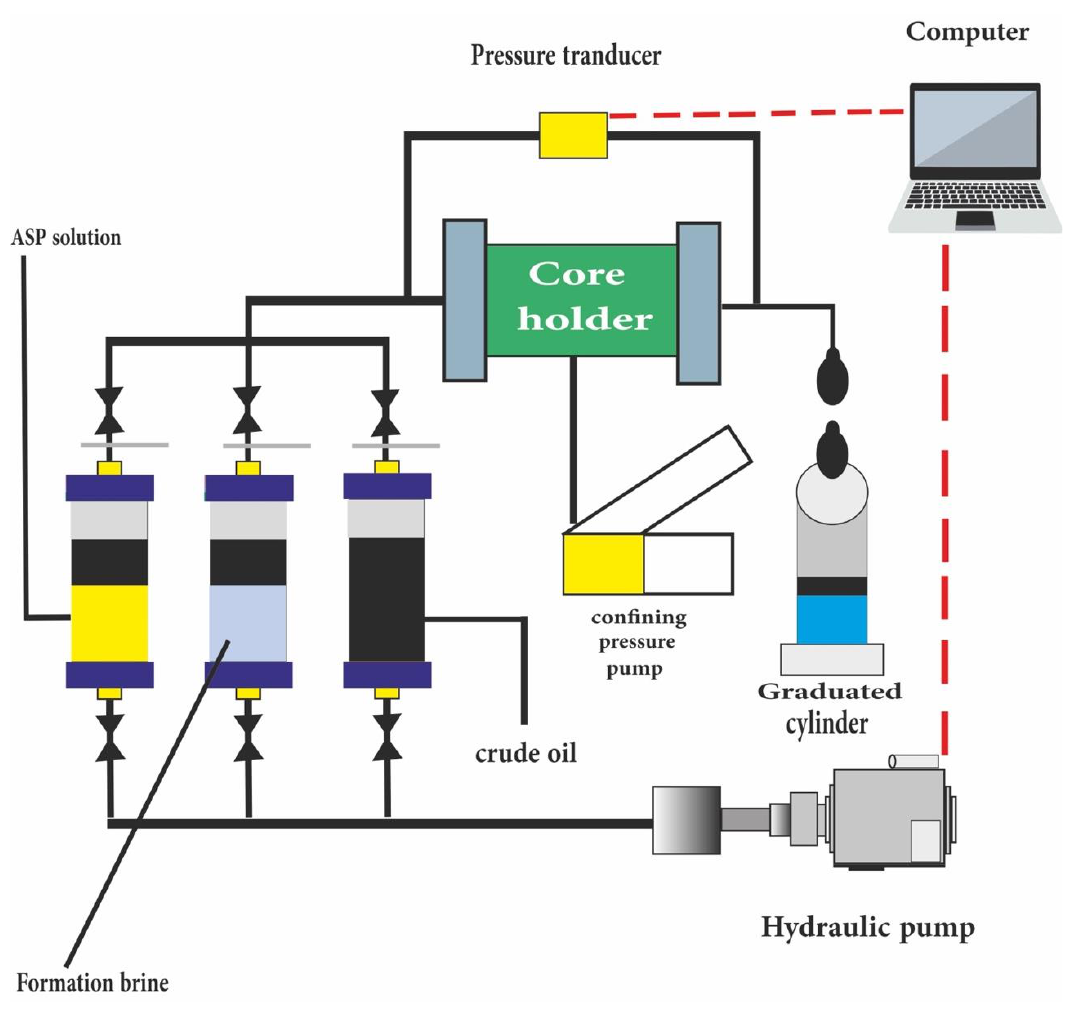
Figure 6. Core – flood